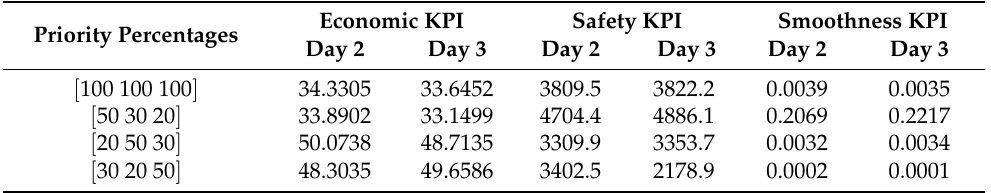
Table 5. KPIs for the DM Strategy (with condition (22)) using the NWS